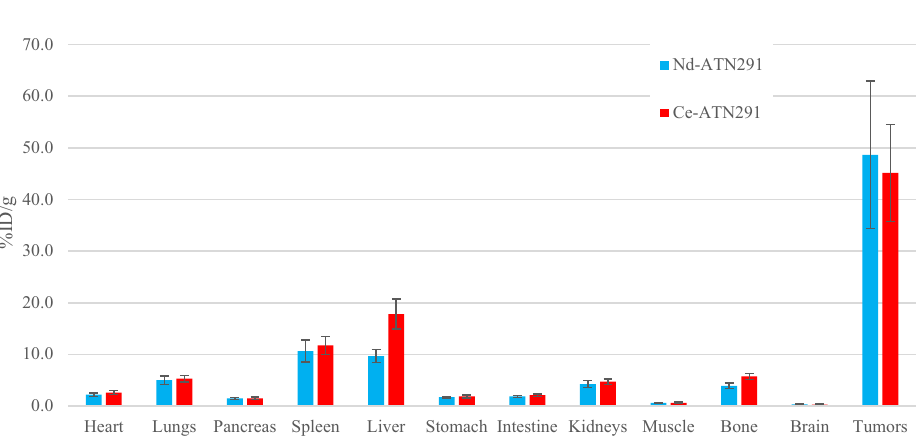
Figure 6. Ex-vivo biodistribution at 5-days after injection with 140 Nd-cDTPA-ATN-291 or 134 Ce-cDTPA-